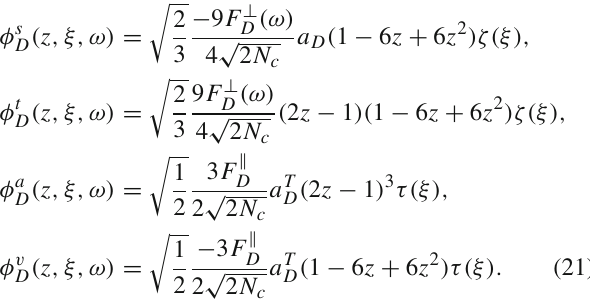
Fig. 1 Typical Feynman diagrams for the quasi-two-body decay B ( s ) → φππ in PQCD, where the black squares stand for the weak vertices, and large (purple) spots on the quark lines denote possible attachments of hard gluons. The green ellipse represent ππ -pair and the red one is the light bachelor φ